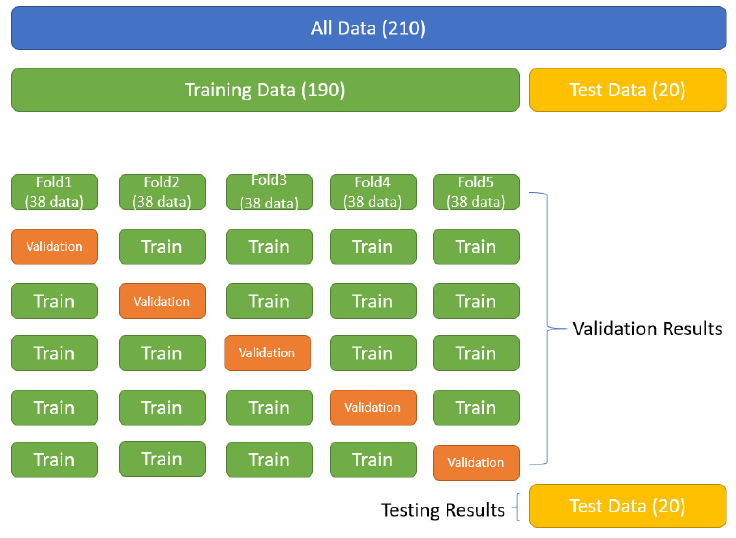
Figure 10. Five-fold, cross-validation algorithm scheme.